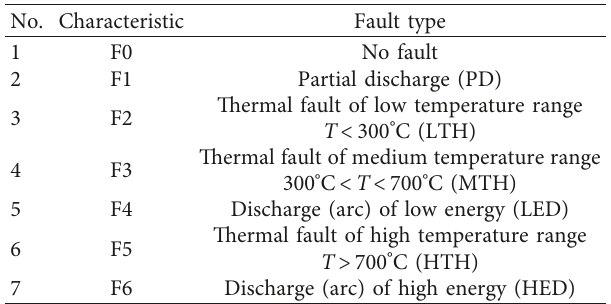
Figure 1: Faults and generated gases. Table 3: Fault categories [24].